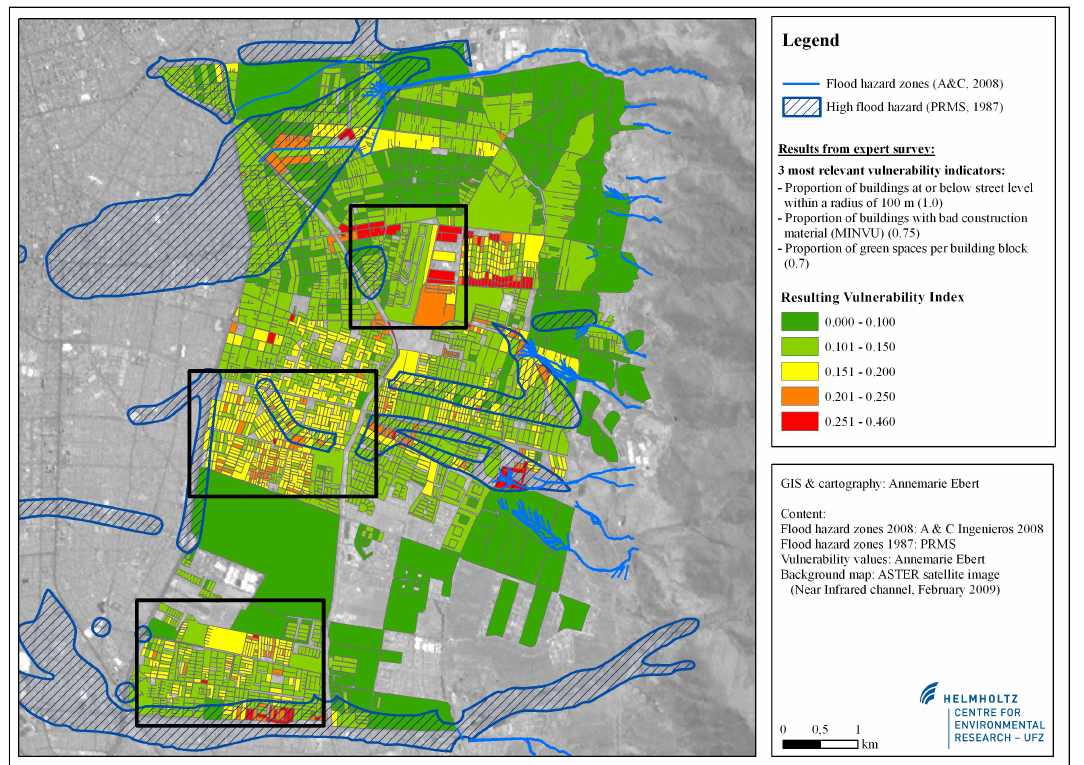
Fig. 4. Vulnerability map of the study area according to the indicator weight evaluations of the